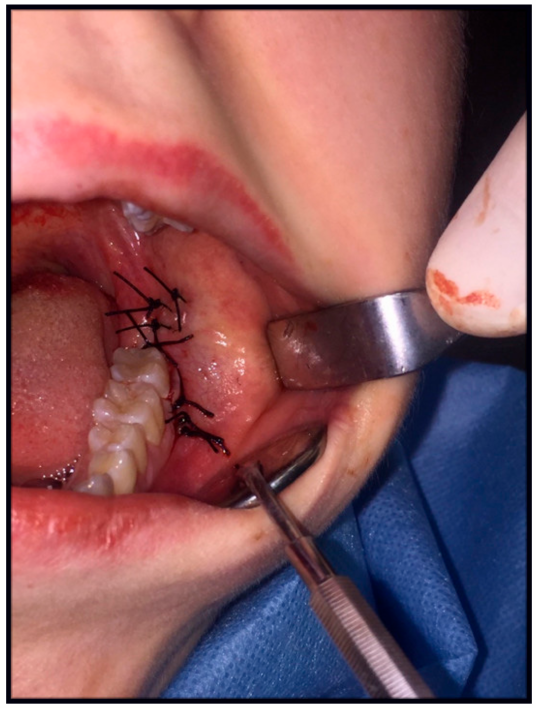
Figure 6. The control group—wound closure with standard knotted sutures.